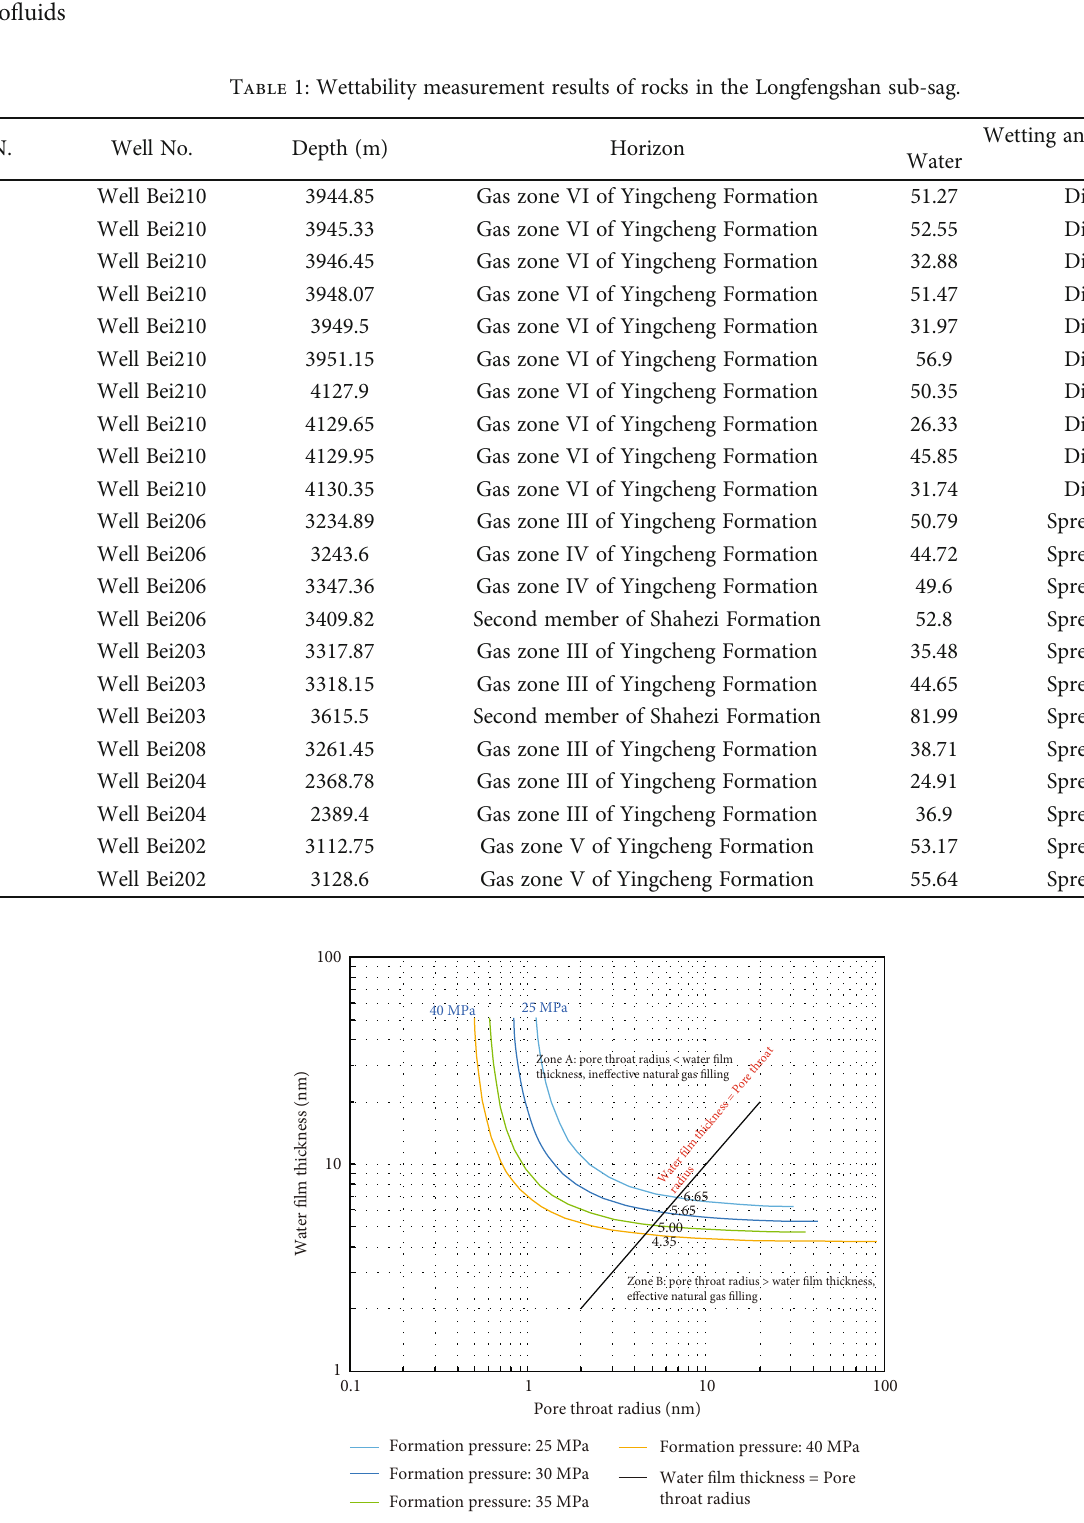
Figure 7: Relationship between the water fi lm thickness and throat radius under di ff erent formation pressures of the Longfengshan